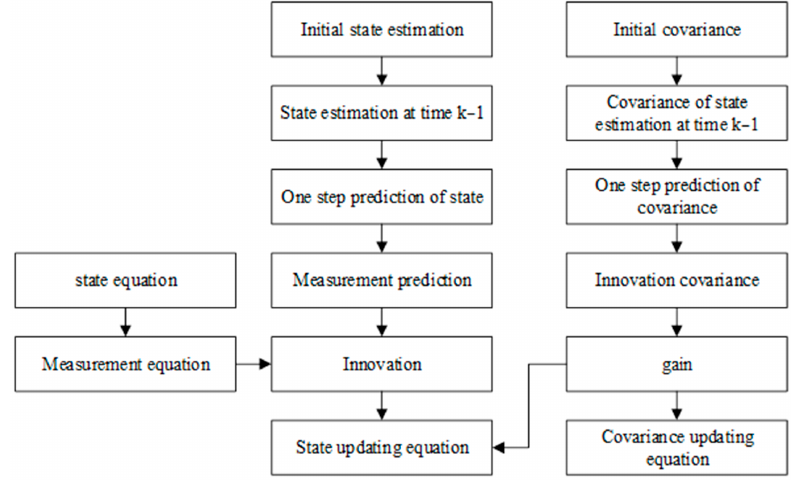
Figure 4. Block diagram of the REMTT filter algorithm.